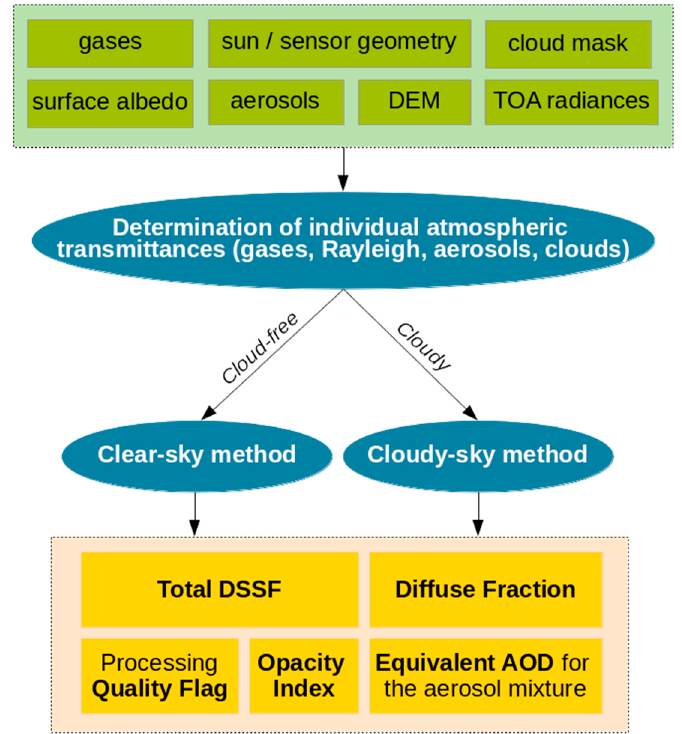
Figure 1. Overview of the flow chart of the MSG-derived Downwelling Surface Shortwave Flux—Total and Diffuse (MDSSFTD) algorithm: in green, the input data used; in blue, the processing steps; and in yellow, the processing outputs.